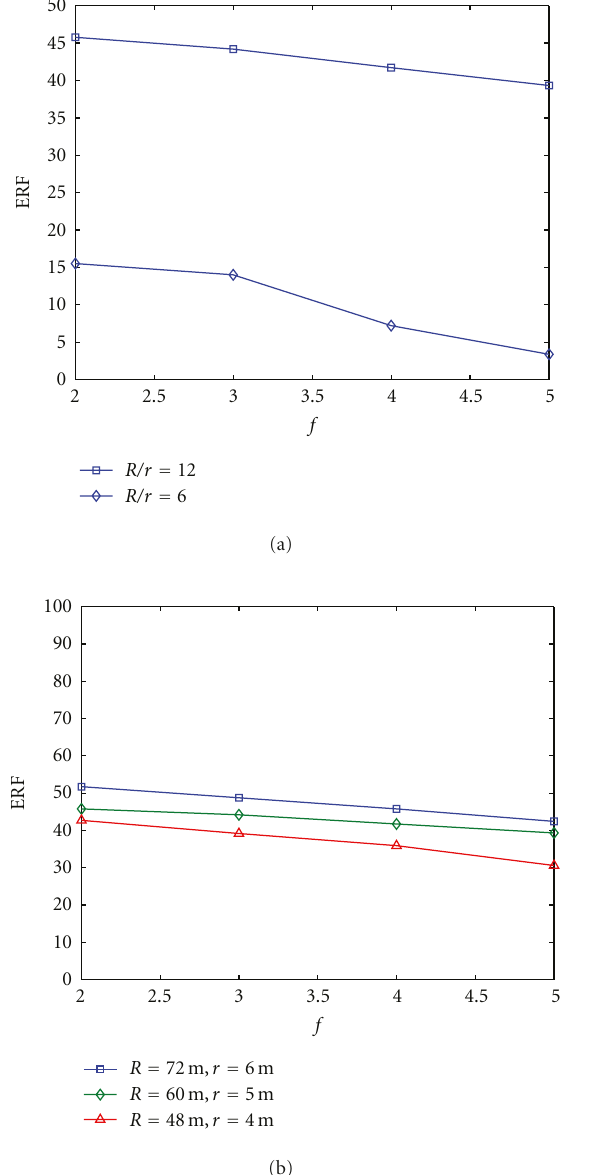
Figure 10: ERF versus f for di ff erent values of R/r (a) and when R/r = 12 (b).